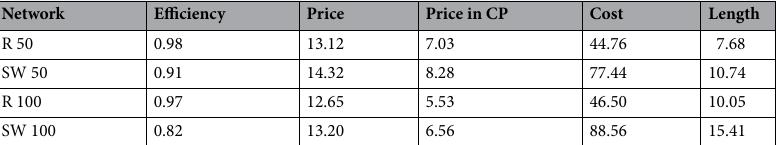
Table 3. Numerical results for larger networks. Efficiency (fraction of rounds in which the cheapest path cost was equal to or less than the threshold), and mean values of the price, price in the cheapest path, cost of the cheapest path, and cheapest path length. Results obtained from numerical simulations with random networks with 50 and 100 nodes (R 50, R 100) for the small-world network with 50 and 100 nodes (R50, R 100).